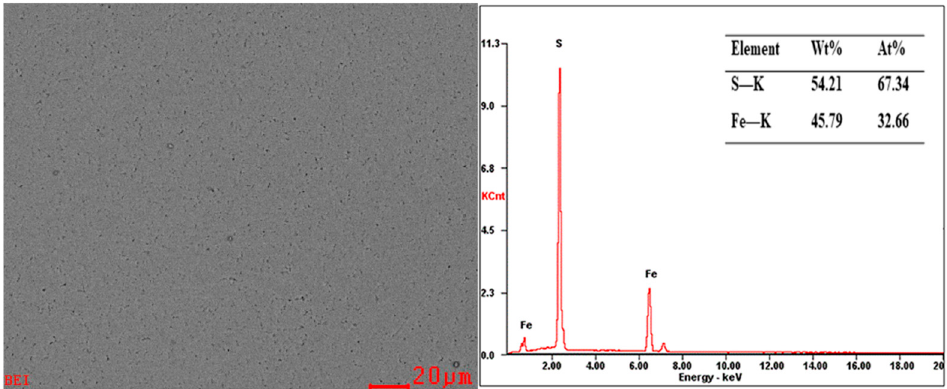
Figure 1. Electron microprobe characterization of a polished pyrite surface.